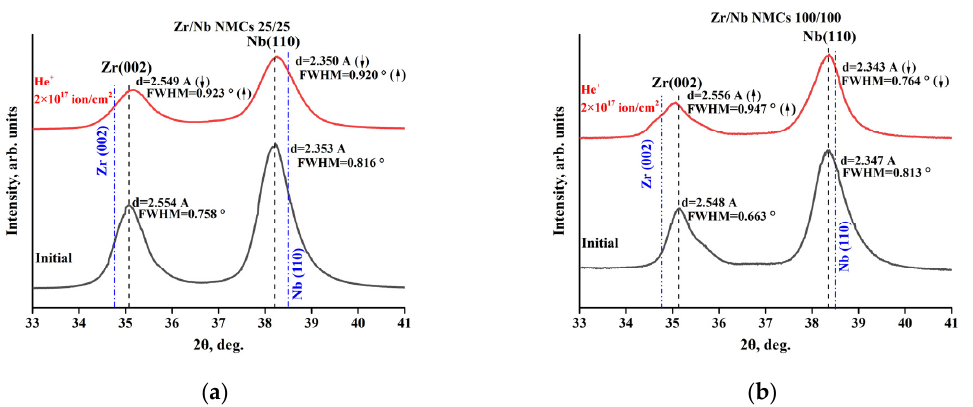
Figure 5. Dependence of the S ( a ) and W ( b ) parameter on the positron energy for Zr/Nb NMCs before and after helium ion irradiation.